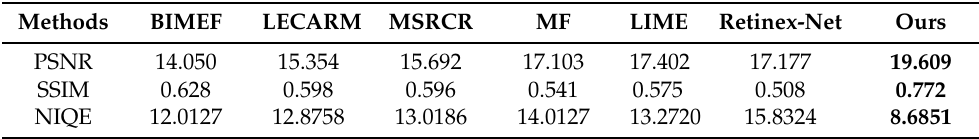
Table 1. Comparison of BIMEF, LECARM, MSRCR, MF, LIME, Retinex-Net and ours in PSNR, SSIM, and